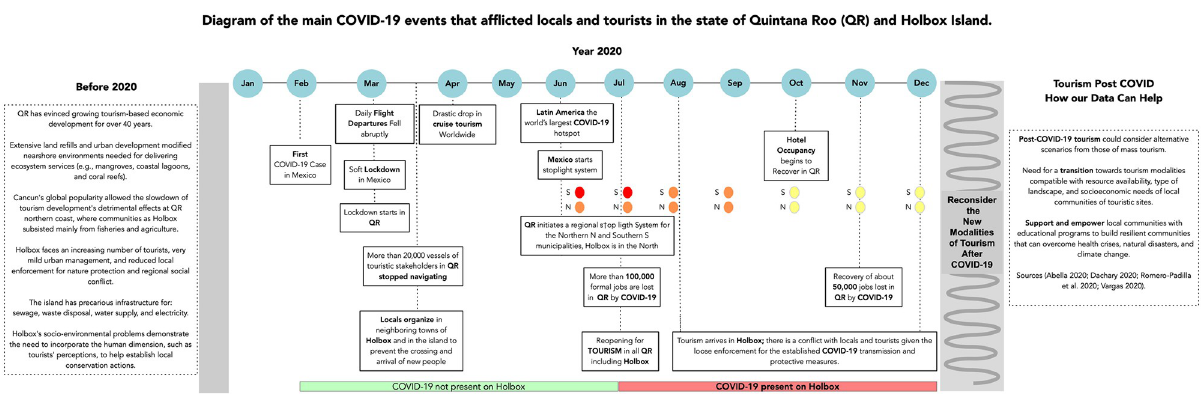
Fig 2. Social and economic events related to COVID-19 afflicted locals and tourists in Quintana Roo (QR) and Holbox. Mexico’s health authorities implemented a national stoplight system in June 2020 to alert residents to the epidemiological risks and provide guidance on restrictions on certain activities. The traffic light system includes four colors: green, yellow, orange, and red. Green indicates a low risk of contagion, and all activities, including school, are allowed. Red indicates a maximum risk of contagion, and only essential economic activities will be allowed. Quintana Roo started a regional traffic light system for the northern (Lazaro Cardenas (where Holbox is located), Tulum, Solidaridad, Cozumel, Puerto Morelos, Benito Juarez, Isla Mujeres); and southern (Felipe Carrillo Puerto, Jose Maria Morelos, Bacalar, Othon P. Blanco) municipalities. The original idea and creation of the figure are by NTRC. Sources for Fig 1 [35, 48–53, 56, 59, 61, 86,